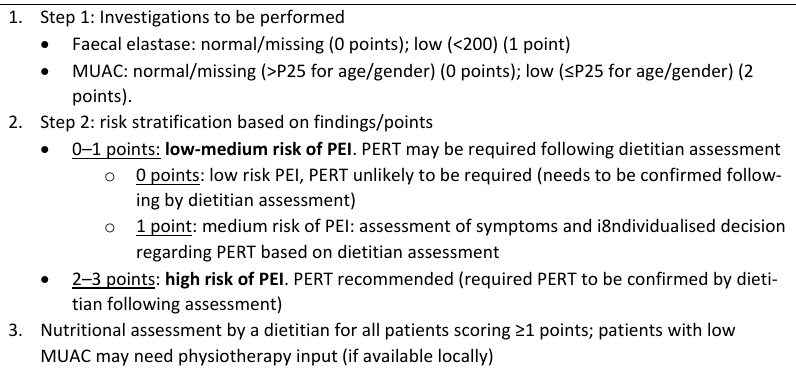
Figure 1. Screening panel for pancreatic exocrine insufficiency. Abbreviations: MUAC, mid-upper arm circumference; PEI, pancreatic exocrine insufficiency; PERT, pancreatic enzyme replacement therapy.